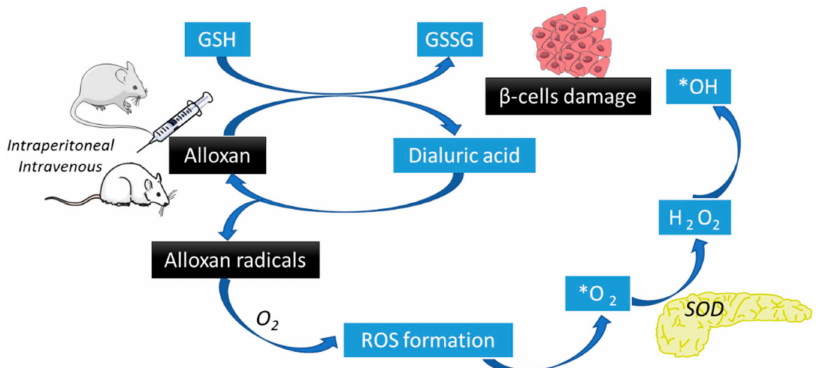
Figure 2. Alloxan induced diabetes mechanism (based on [46]). Alloxan is reduced to dialuric acid and re-oxidized to alloxan producing alloxan radicals and reactive oxygen species (ROS) which undergo dismutation (by superoxide dismutase, SOD) to form hydrogen peroxide (H 2 O 2 ). Hydroxyl radicals (*OH) may also be formed by side reactions. These *OH cause β -cell DNA fragmentation, leading to